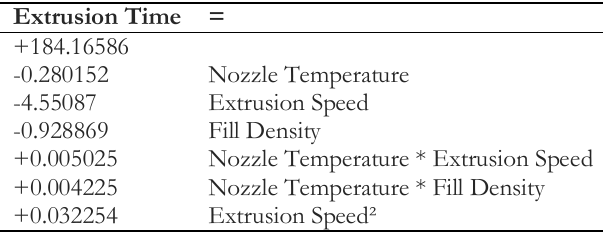
Table 8. Final equation in terms of actual